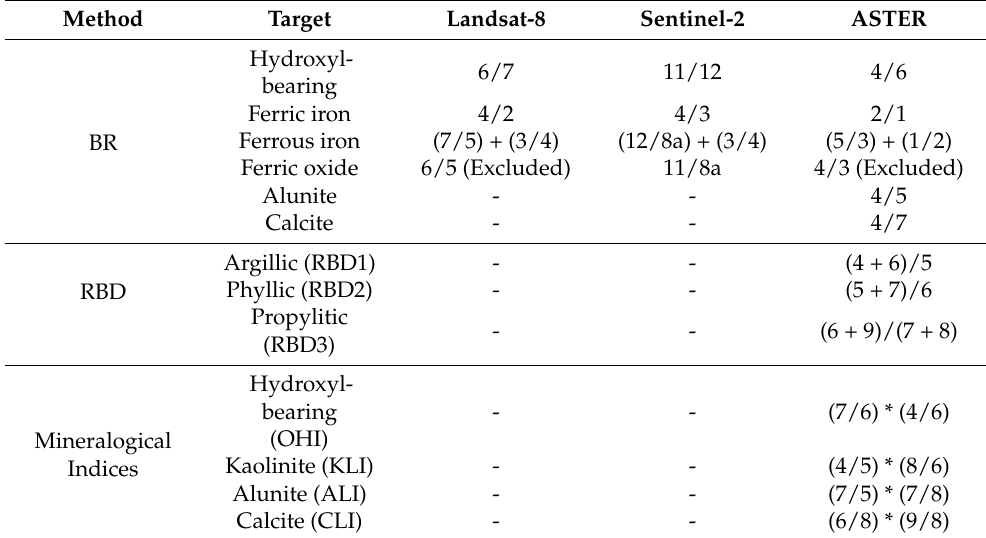
Table 2. Selected BR, RBD, and mineralogical indices of each sensor to map targeted minerals.